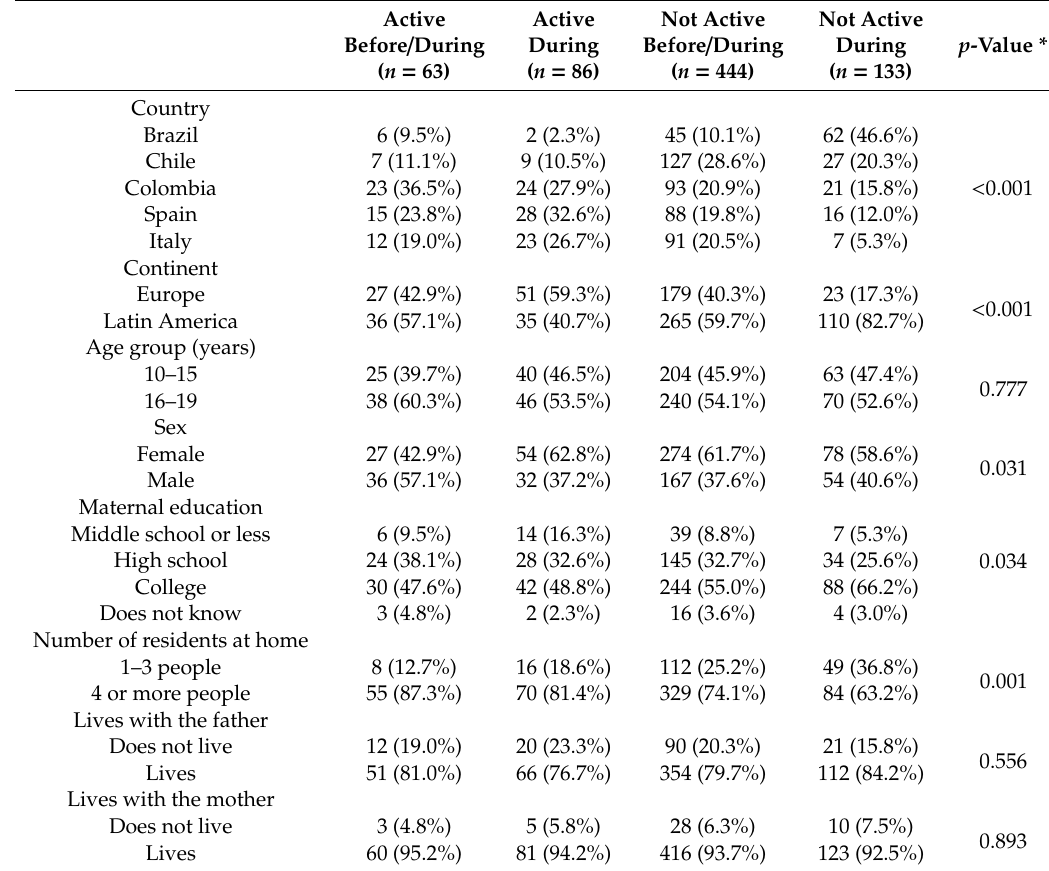
Table 2. General characteristics of the sample according to the physical activity status before and during the quarantine